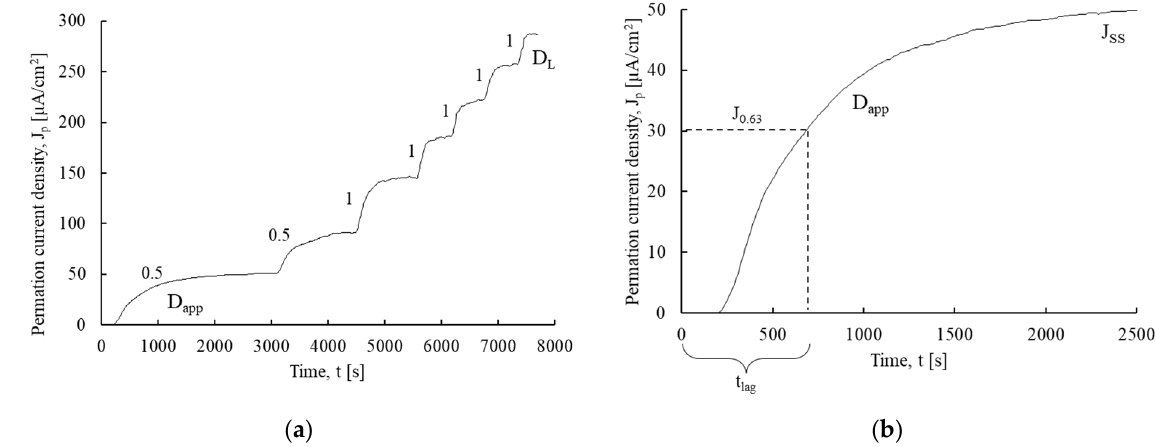
Figure 2. ( a ) Characteristic build-up permeation transients produced increasing the cathodic current density ( J c = 0.5 + 0.5 + 1 + 1 + 1 + 1 + 1 mA/cm 2 ) and ( b ) example of D app calculation in a particular transient